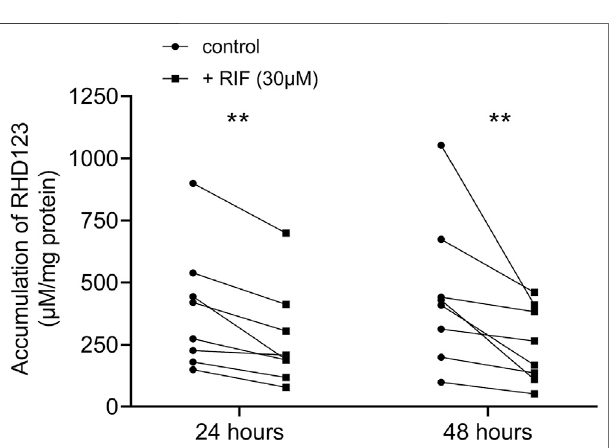
FIGURE 6 | Levels of RHD123 accumulation in hPCISs incubated with 30 µM RIF were signi fi cantly lower than those in RIF-free samples after both 24- and 48-h incubations (Wilcoxon signed-rank tests: *, p < 0.05, and **, p < 0.01). Data are presented as pairwise comparisons between RIF-free (dot) and RIF-treated (square) samples. Each line represents an individual